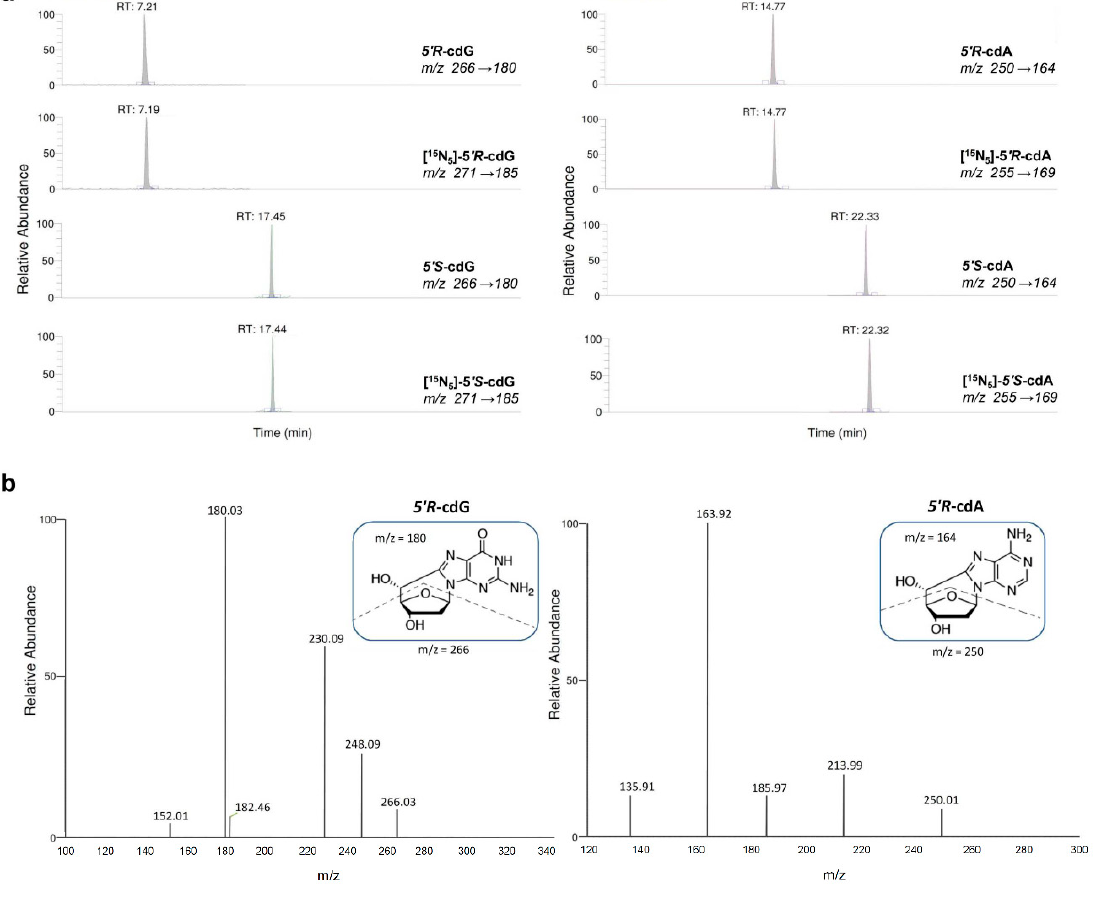
Figure 2. LC-MS / MS analysis. ( a ) MRM chromatograms of quantification ions obtained by LC–MS / MS Figure 2. LC-MS/MS analysis. ( a ) MRM chromatograms of quantification ions obtained by LC–MS/MS analysis: Quantification transitions m / z 266 → 180 (5 (cid:48) R -cdG and 5 (cid:48) S -cdG), m / z 250 → 164 (5 (cid:48) R -cdA analysis: Quantification transitions m/z 266 → 180 (5’ R -cdG and 5’ S -cdG), m/z 250 → 164 (5’ R -cdA and